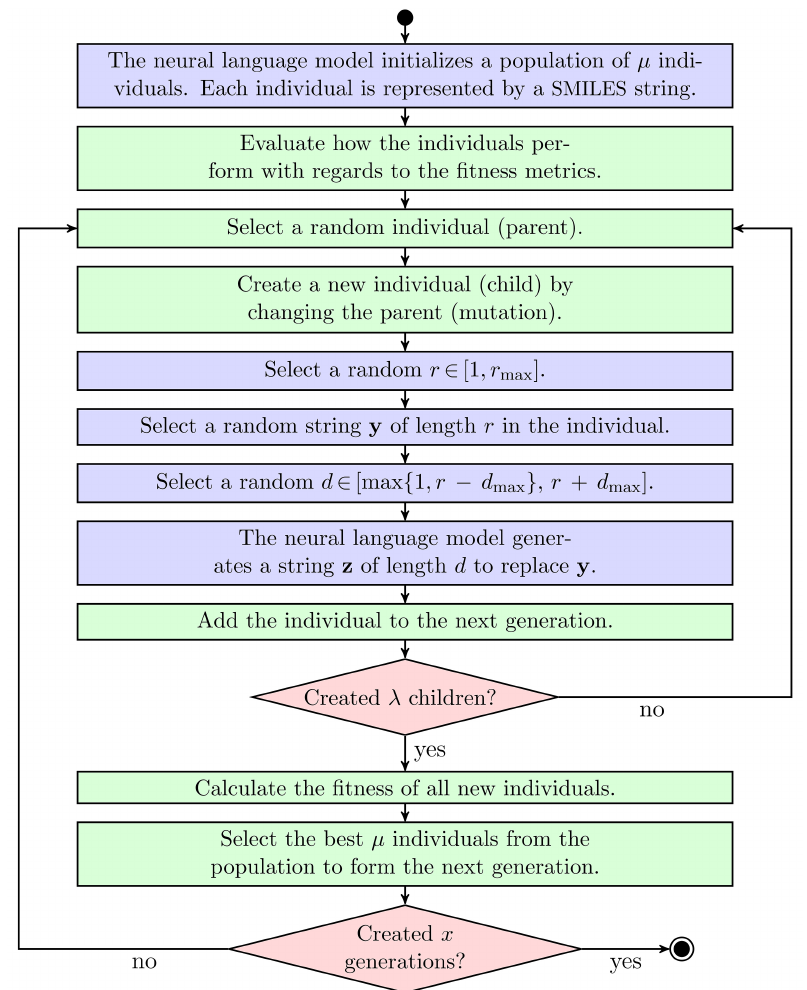
Figure 5. Evolutionary molecular generation algorithm ( EMGA ) presented in the current paper. The in- tegrated language model and the classic EA are represented by blue and green blocks, respectively. The red boxes introduce steps where algorithmic checks are